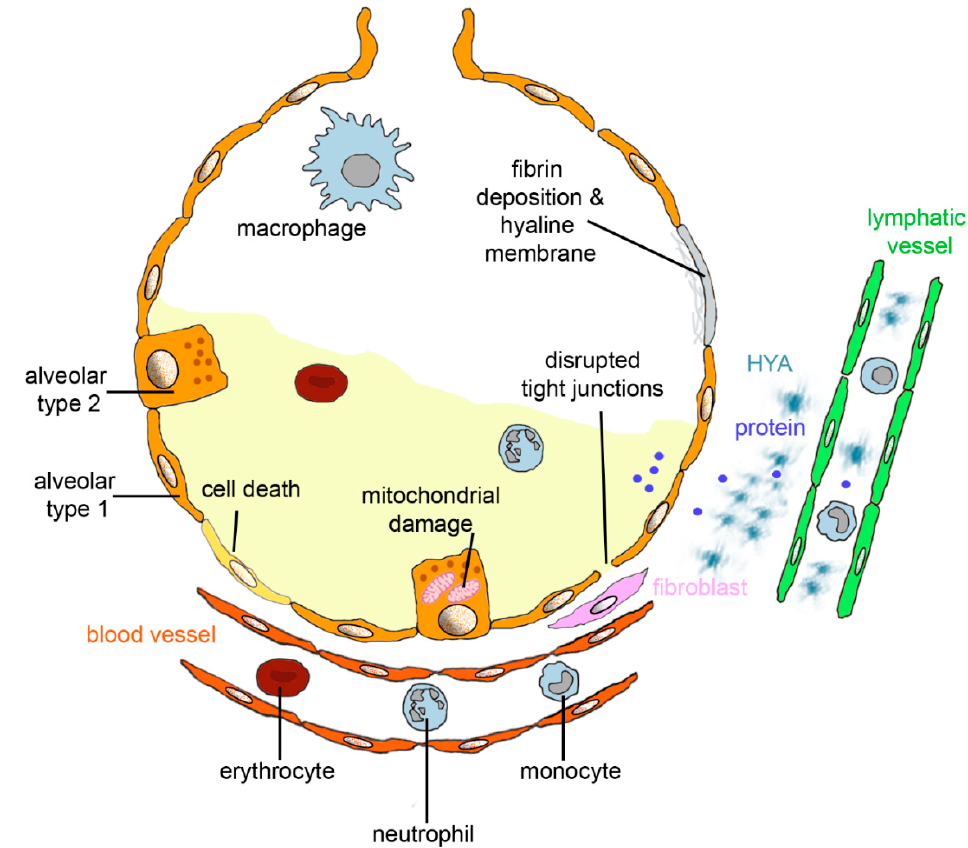
Figure 1. Alveolar changes in acute respiratory distress syndrome (ARDS). Diffuse alveolar damage (DAD) is characterized by death of alveolar epithelial cells; disruption of tight junction between alveolar type 1 cells; and mitochondrial damage and invasion of erythrocytes, monocytes, and neutrophilic granulocytes from blood vessels. Interstitial fluid and protein accumulate in the alveolus, and fluid, protein, and hyaluronan (HYA) in the interstitium. If fluid and proteins are not removed from the alveolar lumen by epithelial sodium channels and Na/K-ATPase or endocytosis by the alveolar epithelium and fluid, then proteins and HYA uptake into lymphatic vessels, and fibrin deposition and formation of hyaline membranes occurs. Excessive formation of collagen by fibroblasts leads to fibrosis.